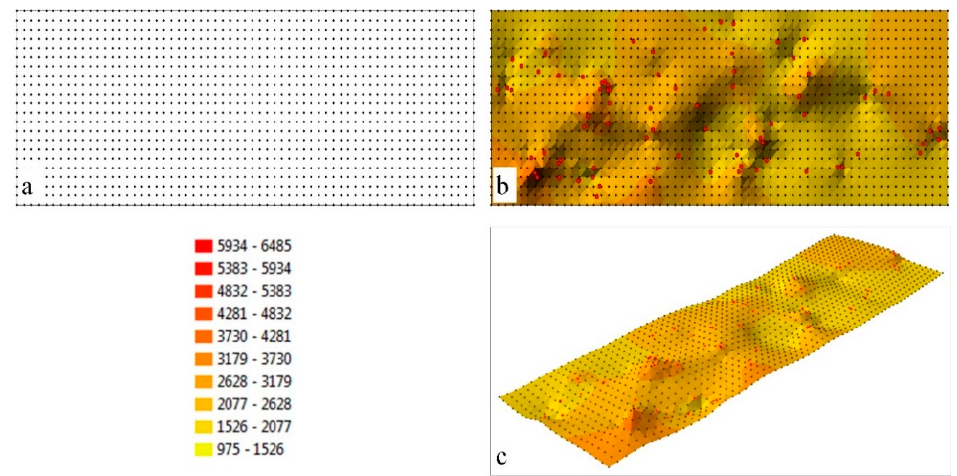
Figure 3. GRID surface generated based on interpolation nodes: ( a ) distribution of interpolation nodes; ( b ) interpolated surface visualized in 2D; ( c ) interpolated surface visualized in 3D. Source: own elaboration.